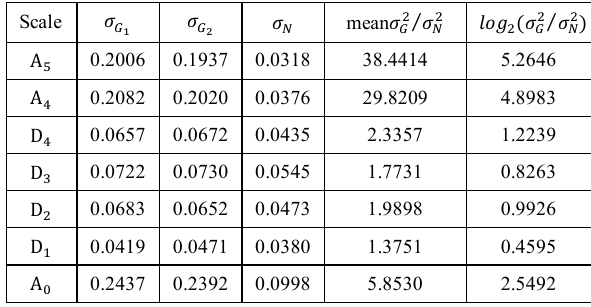
Table 1. SNR at every resolution